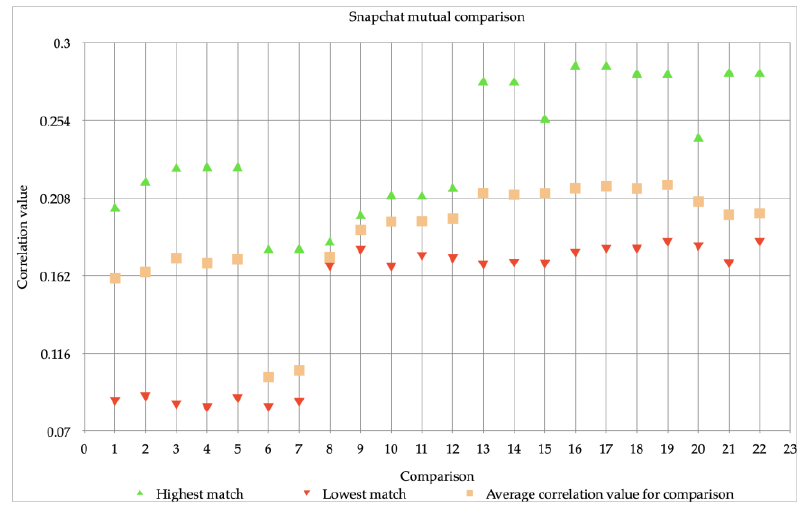
Figure 3. 22 comparisons, done with Snapchat images made with an iPhone 6, all with a resolution of 720 × 1280.